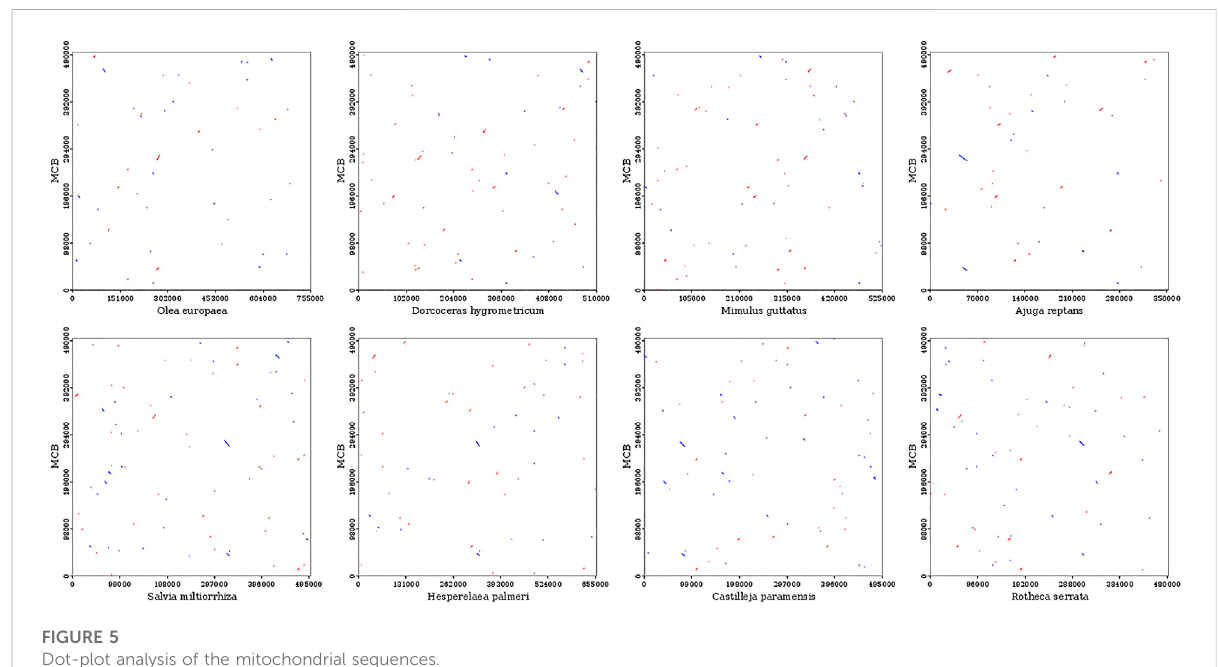
FIGURE 5 Dot-plot analysis of the mitochondrial